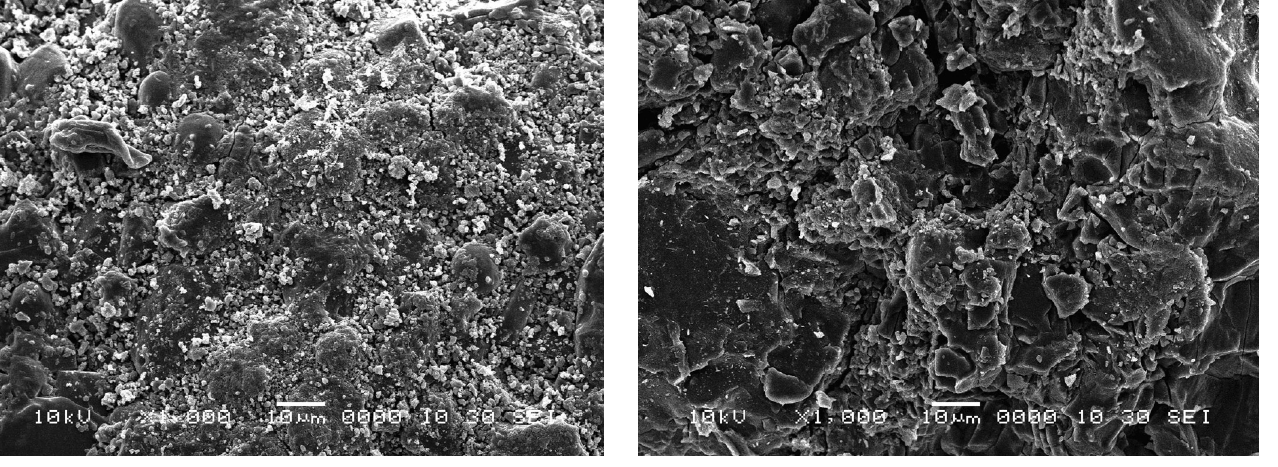
FIGURE 7 - Scanning electron microscopy of polymer coated pellets of an optimized batch F6